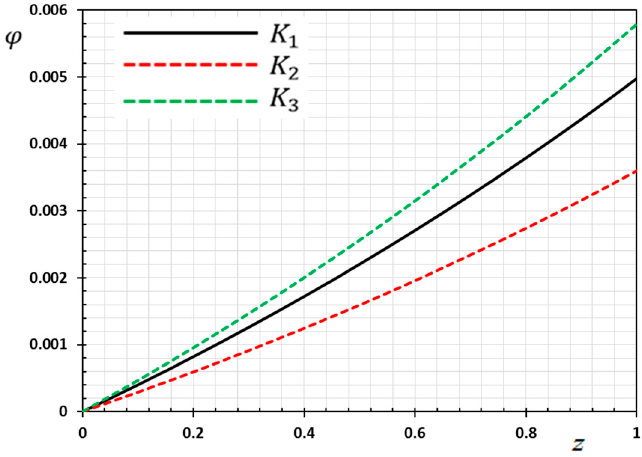
Figure 4. Variation of electric potential 𝜑 versus 𝑧 for different forms of kernel function 𝑘(𝑡 − 𝜉) .